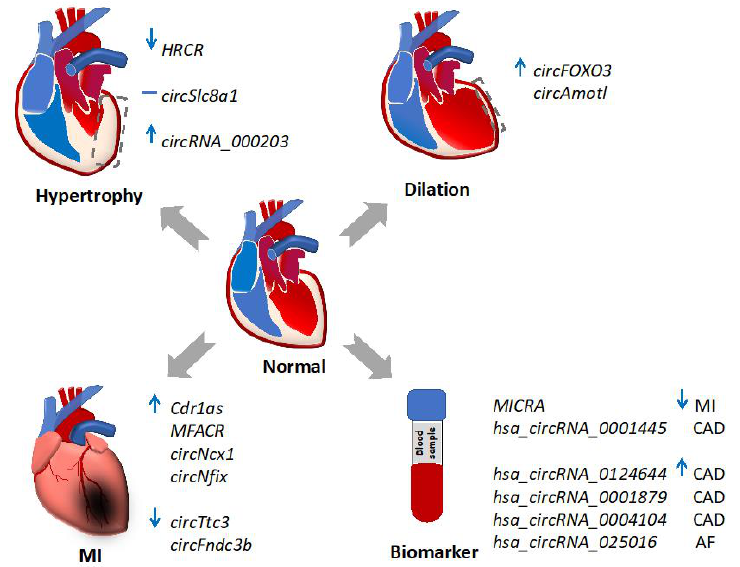
Figure 3. circRNAs as potential targets for the development of theranostics for heart disease. Gray boxes with dashed lines indicate pathological remodeling in cardiac hypertrophy and dilation. Blue arrows depict gene expression changes, with upwards showing elevation and downwards showing repression. MI, myocardial infarction. CAD, coronary artery disease. AF, atrial